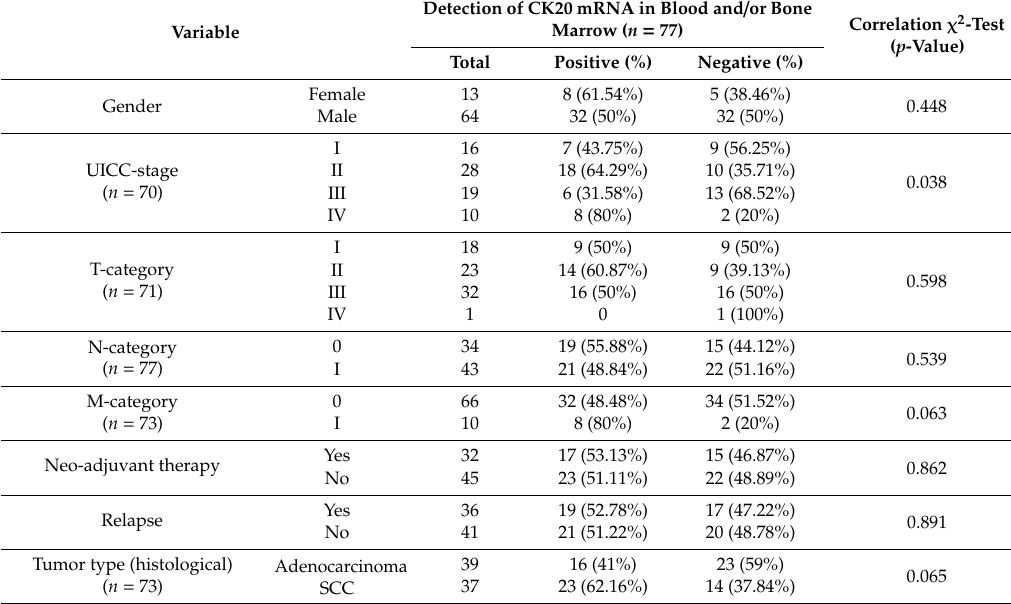
Table 5. Correlation between CK20 mRNA detection in blood and / or bone marrow of esophageal carcinoma patients and clinical parameters.